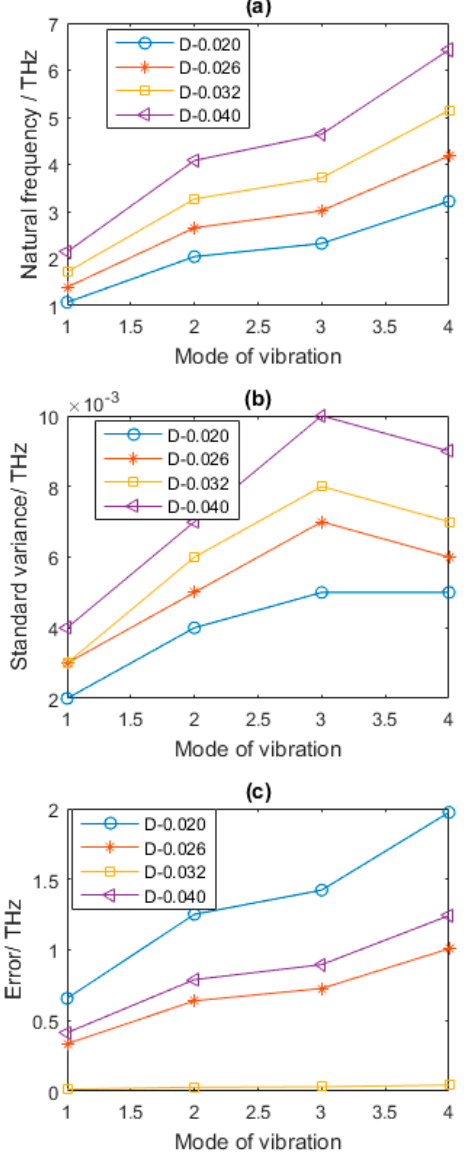
Figure 7. Statistical results of defected graphene sheets with different D ( a – c for mean, standard variance and Error of natural frequency, respectively).